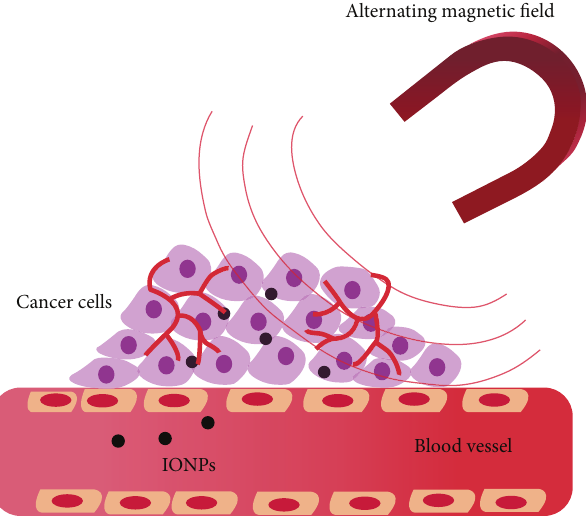
Figure 2: Schematic representation of MFH